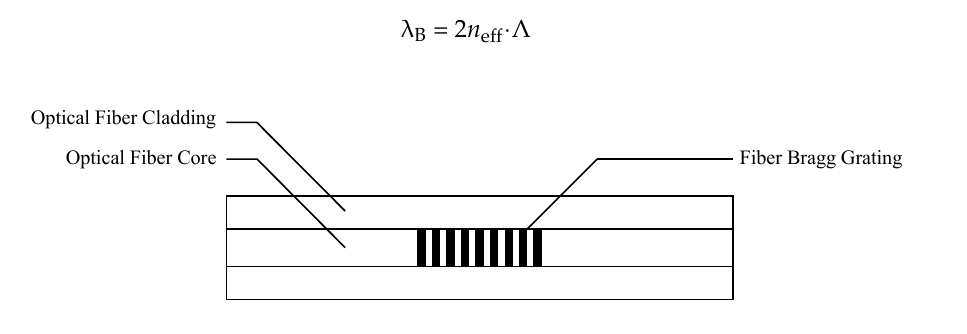
Figure 1. The structure of a typical FBG sensor.